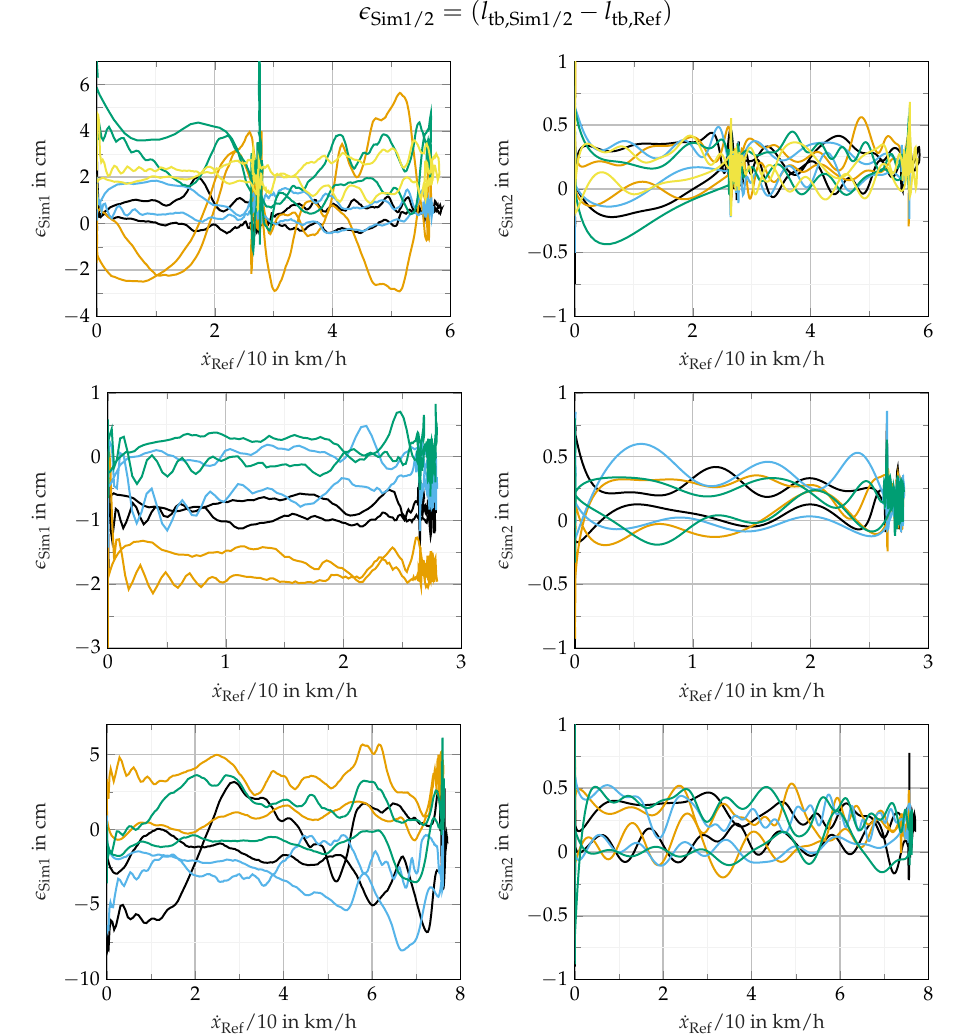
Figure 11. In the left column, (cid:101) Sim1 vs. velocity is shown for the different velocity profiles in the first simulation. In the right column, (cid:101) Sim2 vs. the same profiles is shown in the second simulation. Each trial is visualized with a different